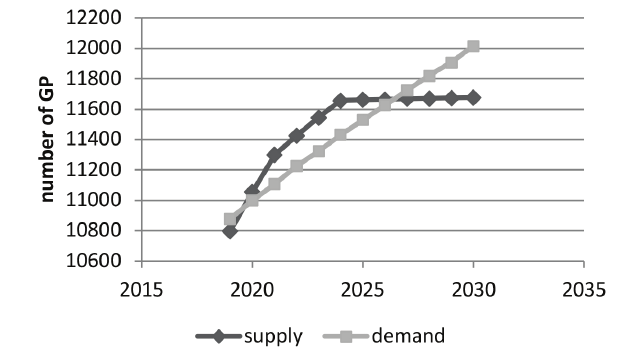
Figure 3 - General Practitioner forecasting